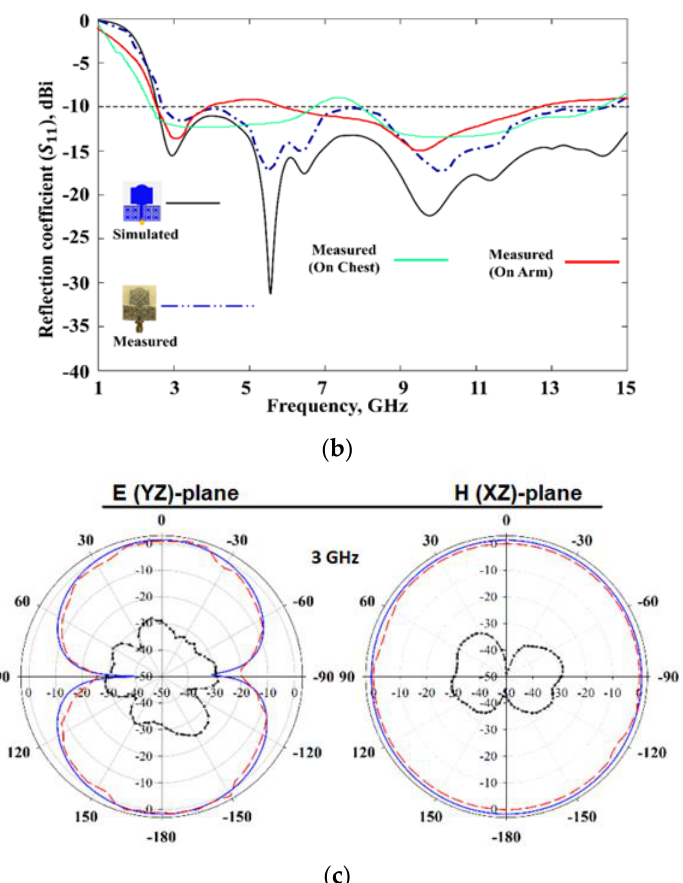
Figure 9. ( a ) Fabricated UWB antenna. ( b ) S11 of the antenna on-body and off-body. ( c ) Radiation patterns. Reprinted ( a – c ) from Ref. [65].